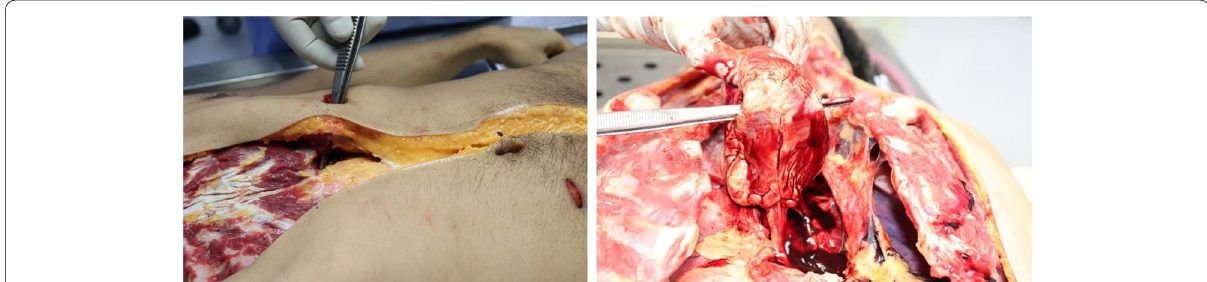
Fig. 3 The chest wound: penetrating the heart ran through the right ventricle, interventricular septum, and left ventricle